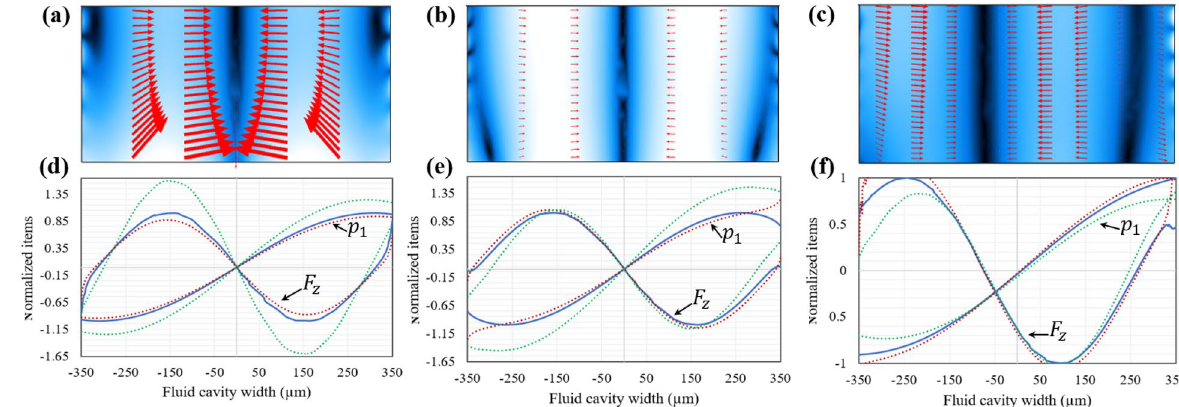
Figure 6. Numerical acoustophoretic simulation of the hybrid aluminum-PDMS microchannel. ( a ) Surface and vector plot of the acoustic radiation force (black (0 pN) to white (72 pN)) for the resonance frequency of 0.908 MHz. ( b ) and ( c ) are the same as ( a ) but respectively plotted for the resonance frequency of 1.083 MHz (surface plot represent black (0 pN) to white (11 pN)) and the resonance frequency of 1.079 MHz (surface plot represent black (0 pN) to white (22.5 pN)). ( d ) line plot of the horizontal acoustic radiation force and corresponding acoustic pressure for the resonance frequency of 0.908 MHz, ( e ) and ( f ) are the same as ( d )